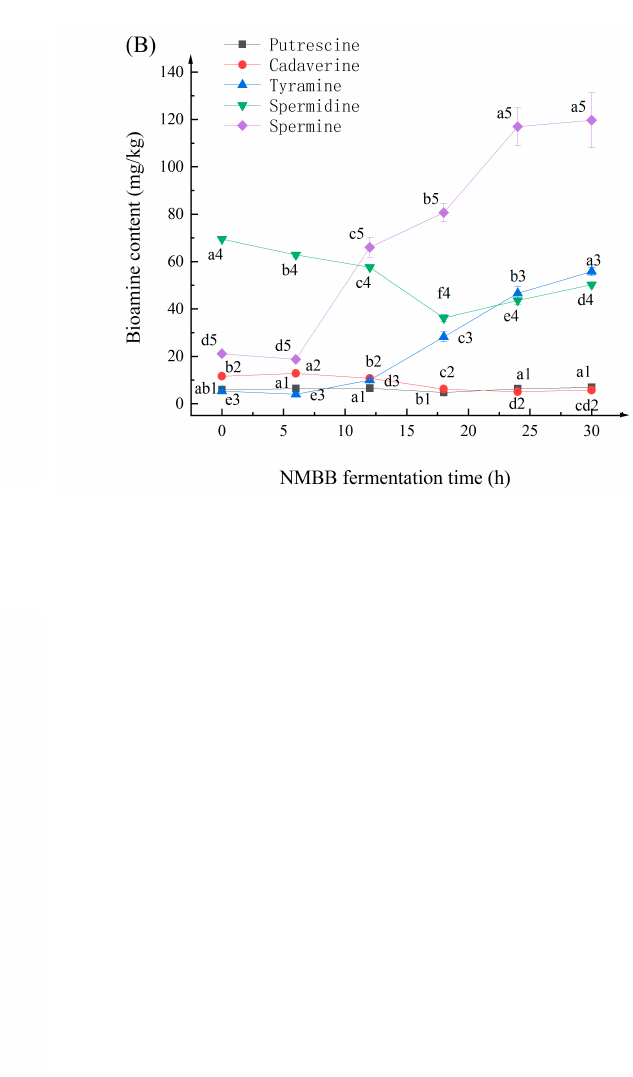
Figure 5. Changes in BAs during natto fermentation by single bacteria (NMB) ( A ) and by two-strain (NMBB) ( B ). Changes in total biogenic amines (TBA) in soybean fermented by single and double bacteria ( C ). Means with different characters (ai–fi, i = 1, 2 ,3, 4 or 5) on the same curve are significantly different ( p < 0.05).